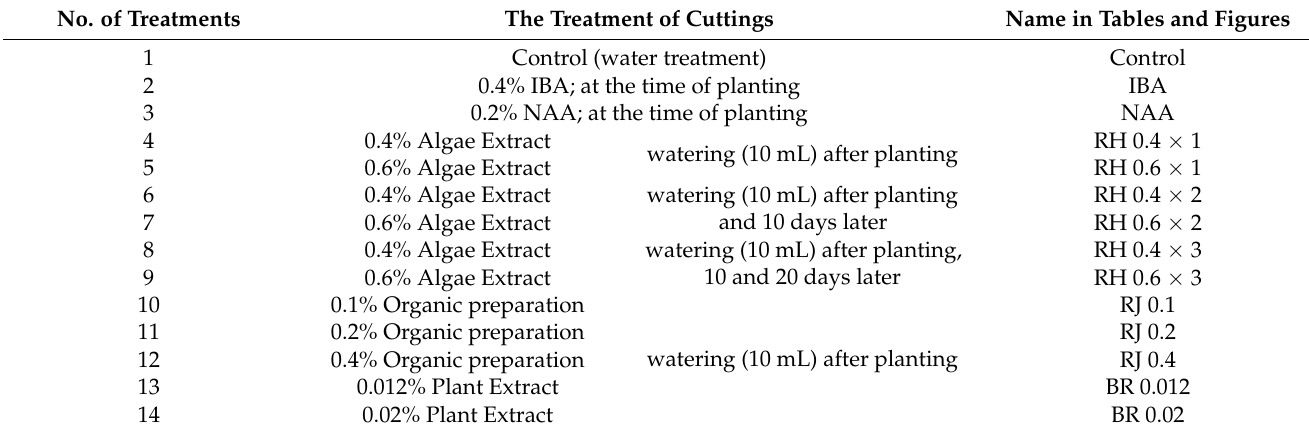
Table 1. The treatment of cuttings of Rosa ‘Hurdal’ at each phenological phase of the experiment. The Treatment of